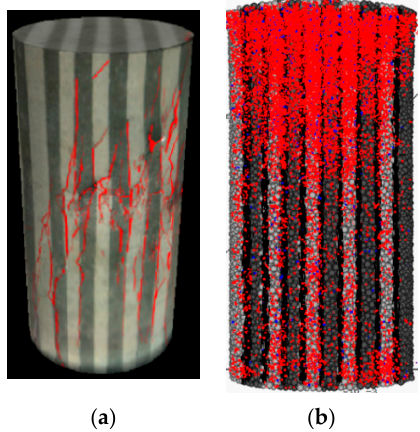
Figure 14. Failure modes of transversely isotropic jointed rock model having dip angle of 90°: ( a ) experiment sample, and ( b ) numerical sample. (Note that the failure images of physical samples were adopted from Ref. [23]).